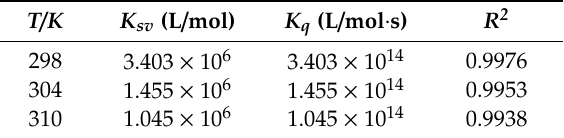
Figure 8. Stern-Volmer plots of Pv quenched by GA at di ff erent temperatures. Figure 8. Stern‐Volmer plots of Pv quenched by GA at different temperatures. Table 2. Stern-Volmer constant of the interaction between GA and Pv at di ff erent temperatures. Table 2. Stern‐Volmer constant of the interaction between GA and Pv at different temperatures.